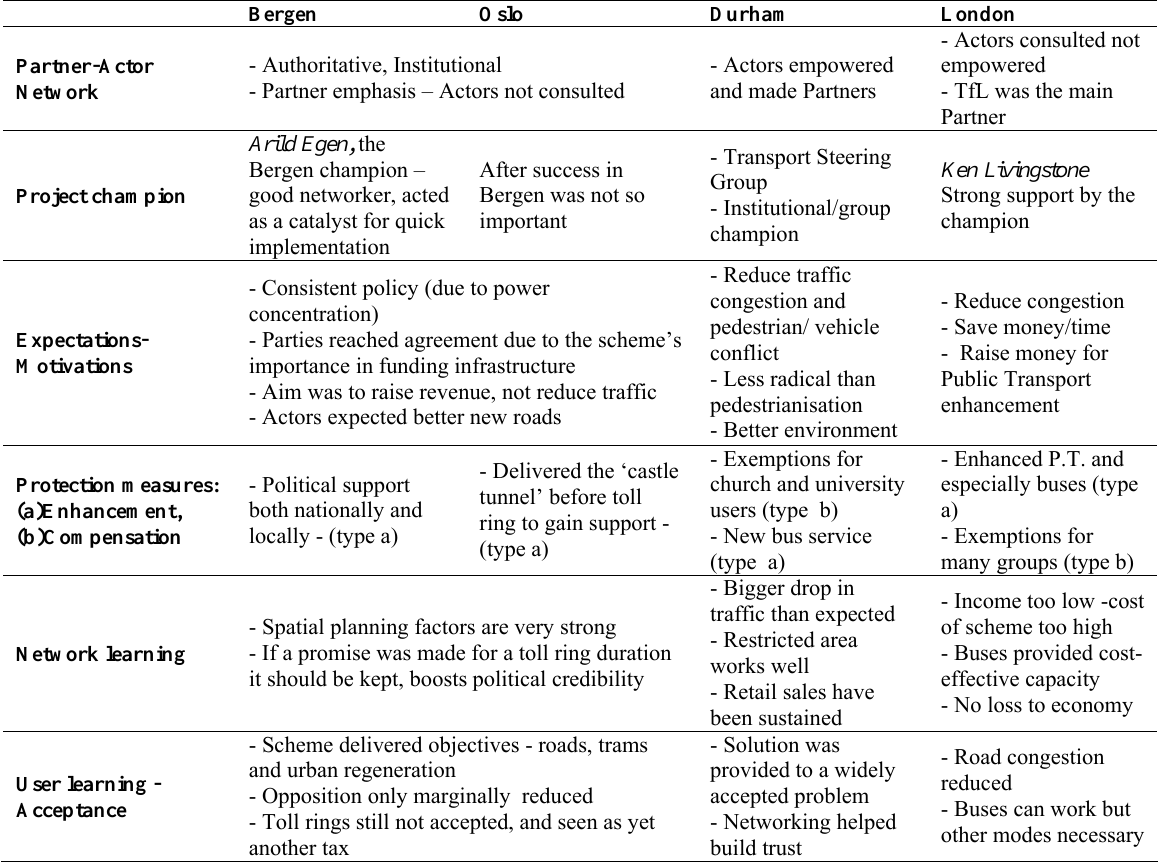
Table 2. Summary of key factors applied to the various